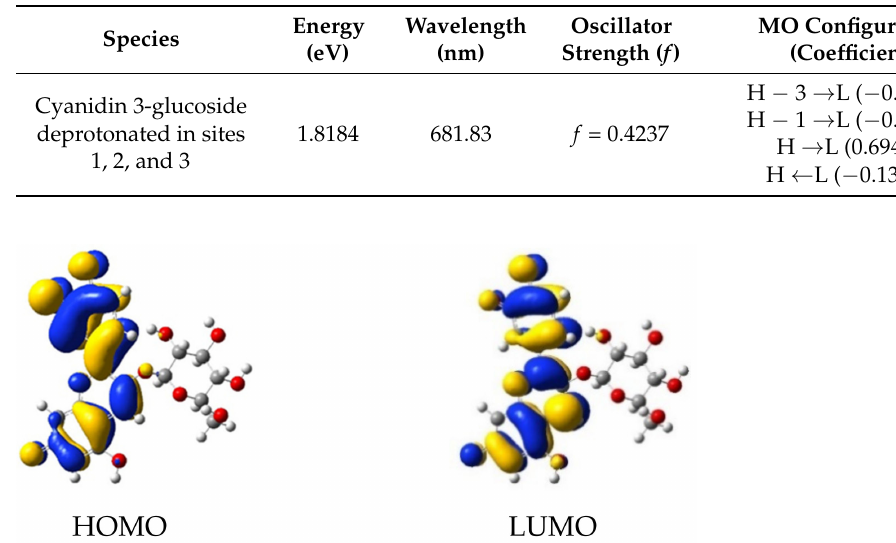
Table 1. Excitation energy and the oscillator strength ( f ) for cyanidin 3-glucoside deprotonated in sites 1, 2, and 3 computed at the TDDFT/B3LYP/DGDZVP in water.